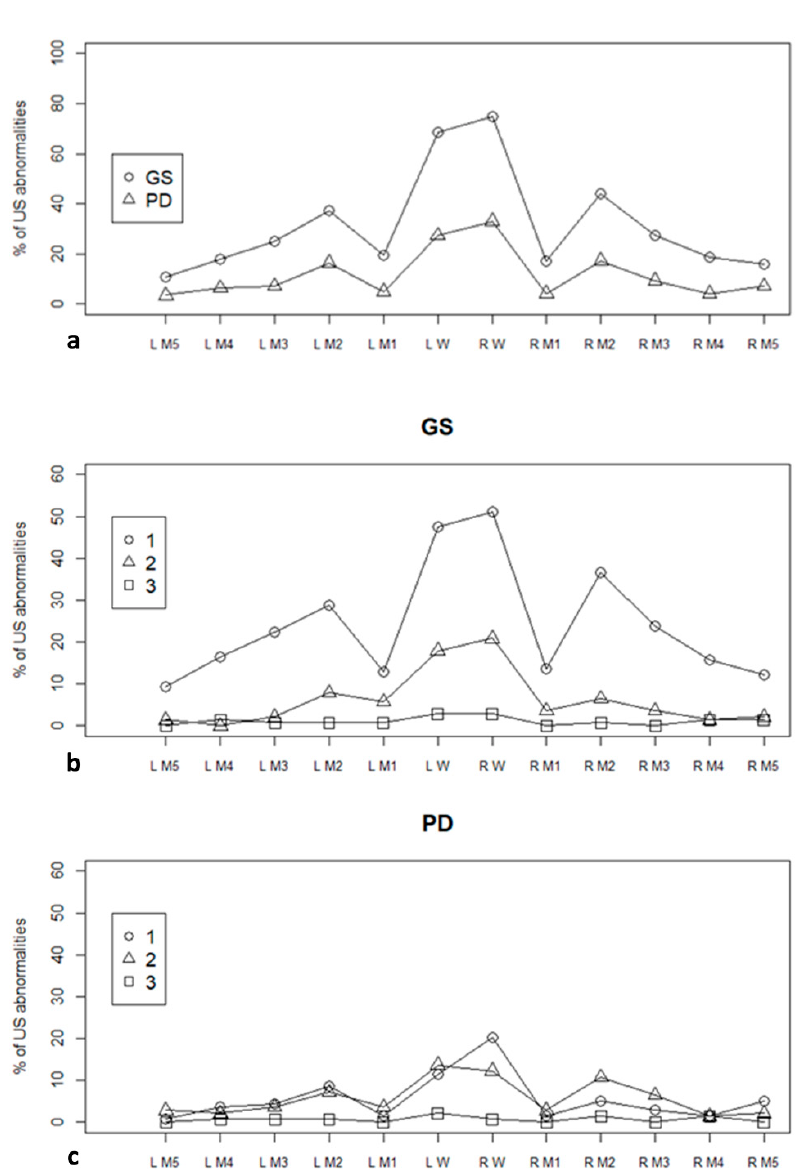
Figure 1. Prevalence of ultrasonographic abnormalities compared to the total number of scanned joints, according to the joint site and the type of lesion. ( a ) proportion of ultrasonographic abnormalities of any grade; ( b ) proportion of grey scale abnormalities, presented according to the grade of severity; ( c ) proportion of power Doppler abnormalities, presented according to the grade of severity. US: ultrasound; GS: grey scale; PD: power Doppler; L: left; R: right; M: metacarpophalangeal joint; W: wrist.